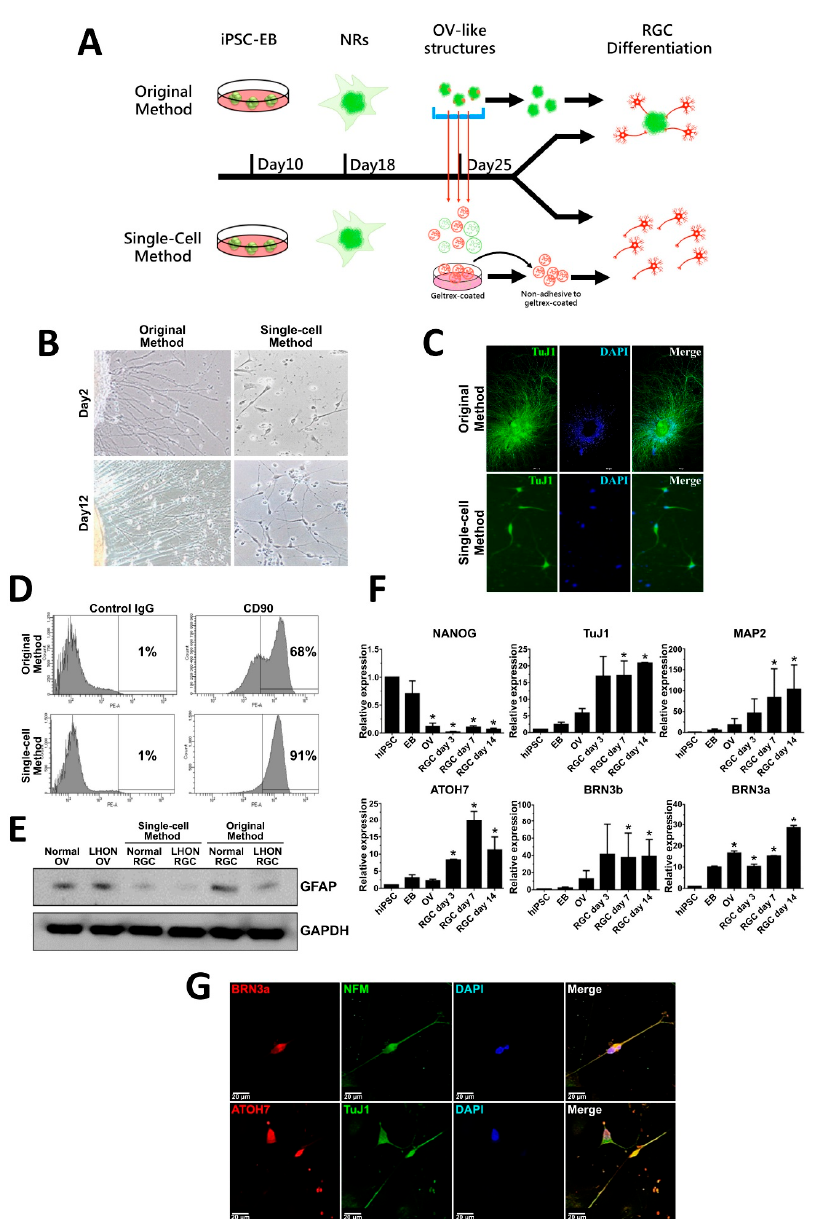
Figure 2. Differentiation of human-induced pluripotent stem cells (hiPSCs) from retinal ganglion cells (RGCs). ( A ) Schematic showing the timeline and procedure of differentiation of RGCs from hiPSCs by using the original and modified single-cell methods. ( B ) Bright field images of 2-day and 12-day normal hiPSC-derived RGCs obtained by the original and single-cell methods. ( C ) Immunostaining of RGC marker TuJ1 in the normal hiPSC-derived RGCs obtained by both methods. ( D ) Flow cytometry analysis of the proportion of CD90-expressing 21-day normal hiPSC-derived RGCs obtained by both methods. ( E ) Western blot showing expression of glial marker GFAP in the population of 21-day normal hiPSC-derived RGCs obtained by both methods. ( F ) qRT-PCR analysis of expression of neuronal / RGC markers and pluripotency marker NANOG in a time course of di ff erentiation of hiPSCs to RGCs at the indicated stages. The mean fold change relative to hiPSC from three biological replicates is shown with standard deviation error bars. EB—embryoid body, NR—neural rosette, OV—optic vesicle, RGC—retinal ganglion cell, hiPSC—human-induced pluripotent stem cell. * p < 0.05 (Student’s t -test) as compared to hiPSC. ( G ) Immunostaining showing expression of RGC-specific markers BRN3a, NFM, ATOH7 and TuJ1 in 21-day normal RGCs obtained by single-cell method. Nuclei stained with DAPI. Scale bar: 20 µ